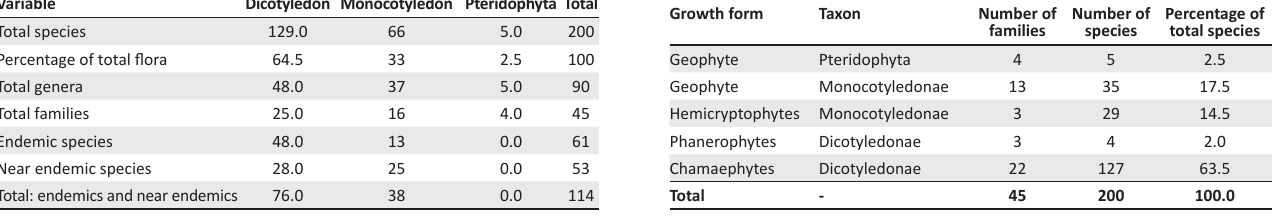
TABLE 1: Summary of the floral composition of Drakensberg inselberg summits. Variable